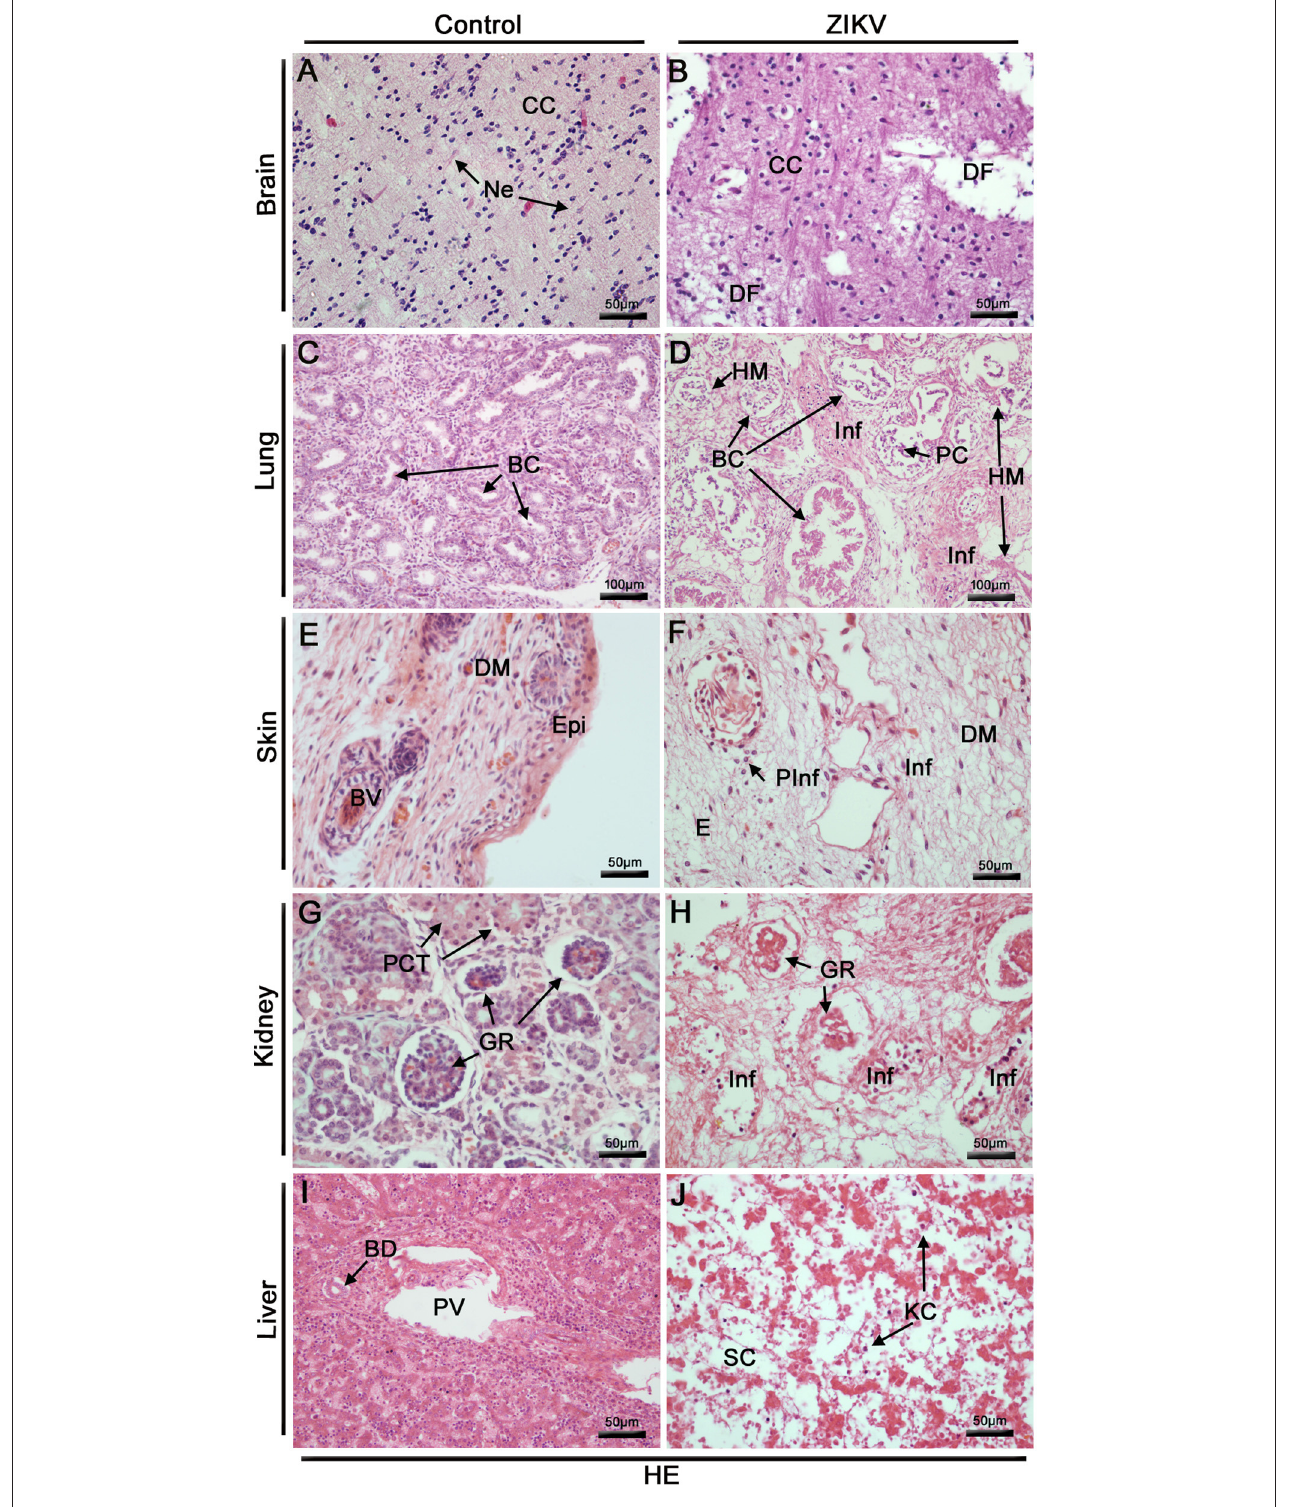
FIGURE 3 | Histopathological analysis of the fetal organs. (A–J) All tissues were stained with H. E. (A) Brain of a non-ZIKV case presenting normal aspect: cerebral cortex (CC) and neurons (Ne). (B) Brain of a ZIKV infected fetus, presenting areas of degenerated nerve fibers (DF). (C) Lung section of a control fetus showing normal bronchioles (BC). (D) Injuries in fetal lung infected by ZIKV: disorganized bronchioles (DBC) with loss of cylindrical appearance, focal areas of hyaline membrane (HM),